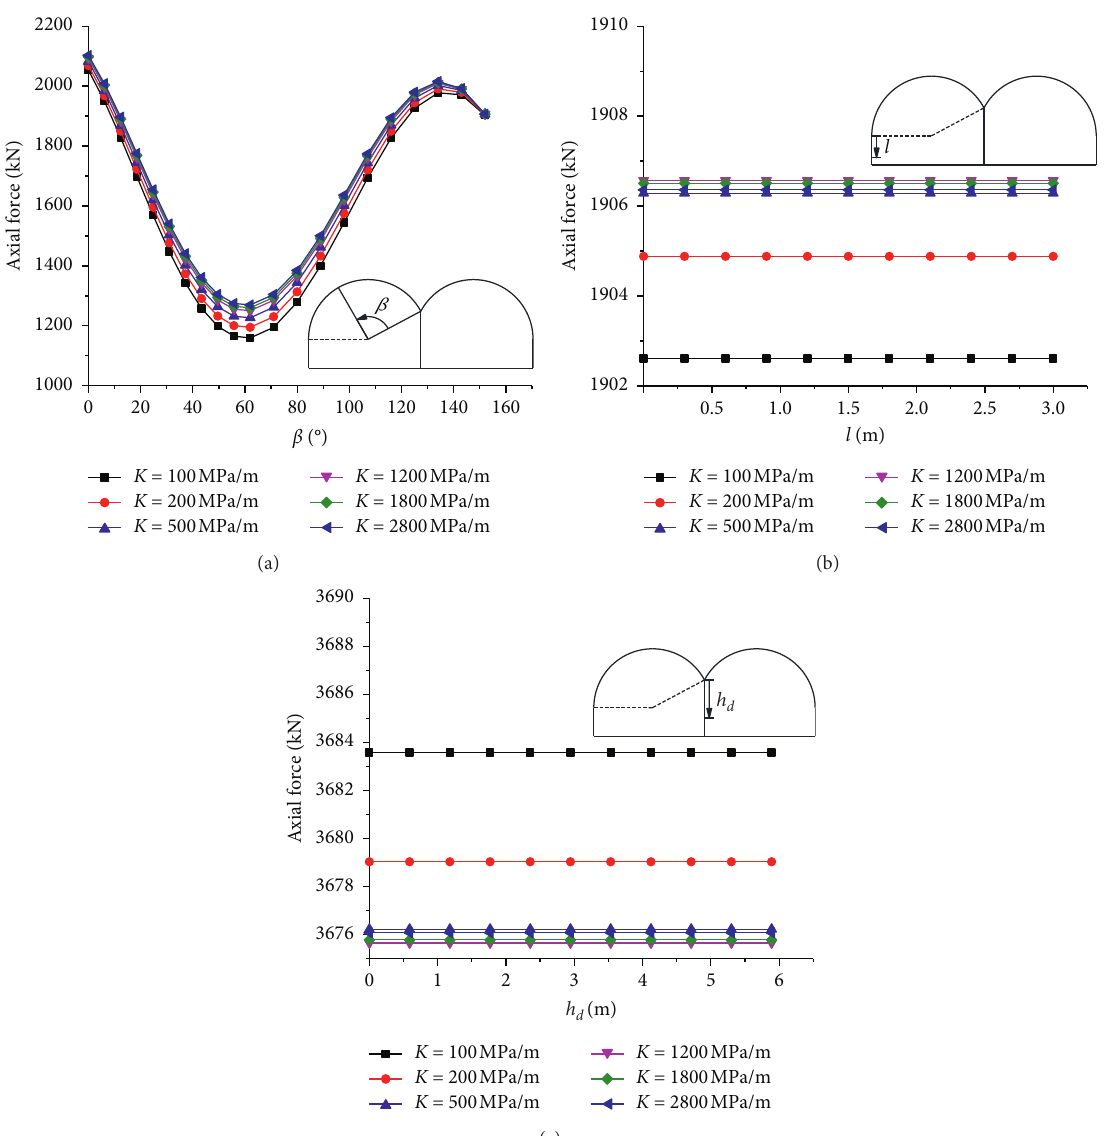
Figure 16: Variations of axial force with ( K ): (a) along the arch ring; (b) along the side wall; (c) along the middle